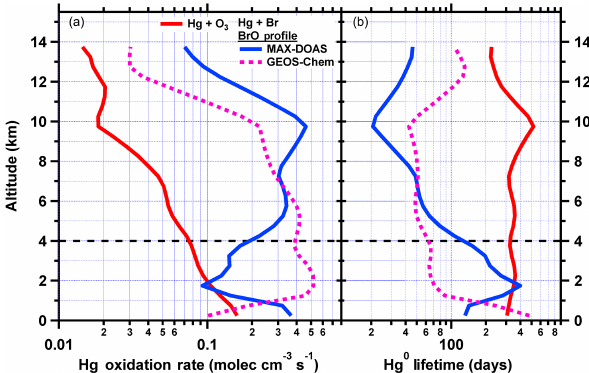
Figure 7. Box model results of the rate of mercury oxidation as a function of altitude for two species: (1) ozone (red); and (2) bromine radicals (solid blue: MAX-DOAS; dashed pink: GEOS-Chem) (a) ; the corresponding lifetimes are found in (b) . The black dashed line at 4km shows where measurement sensitivity starts to drop because of the decreasing amount of BrO (the measured parameter) in the lower layers of the